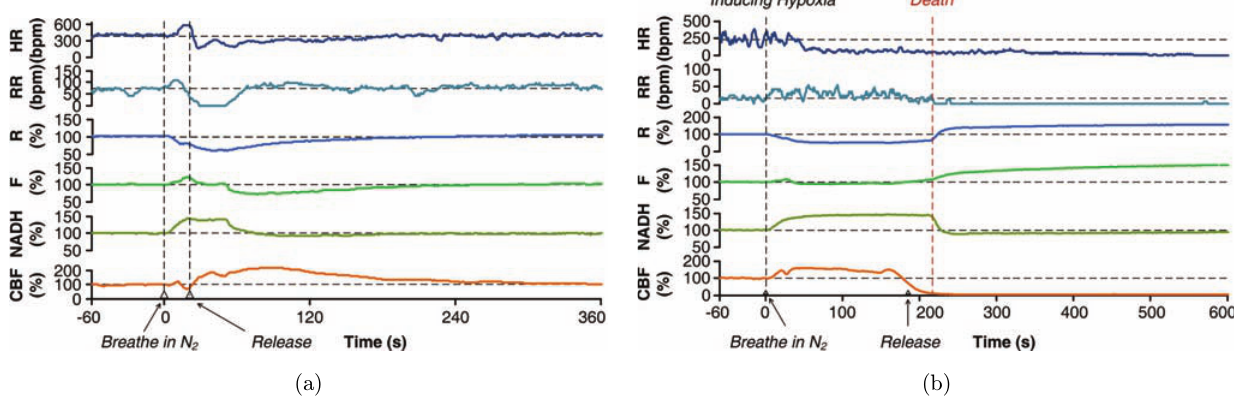
Fig. 1. Typical demonstrations of multiparametric monitoring during the procedure of hypoxic hypoxia in (a) a rescued rat and (b) a rat died in the end. The horizontal axis represents time (seconds). The rat breathed in nitrogen at the time point 0, and the baselines, shown as horizontal dashes, was calculated as the mean values of each parameter during the 60 s before breathing in nitrogen. The vertical dashes tell the time when starting breathing in nitrogen (in black) and brain death (in red). Monitored parameters are listed from top to bottom as heart rate (HR), respiration rate (RR), re°ectance change (R), °uorescence change (F), corrected NADH change (NADH) and cerebral blood °ow change